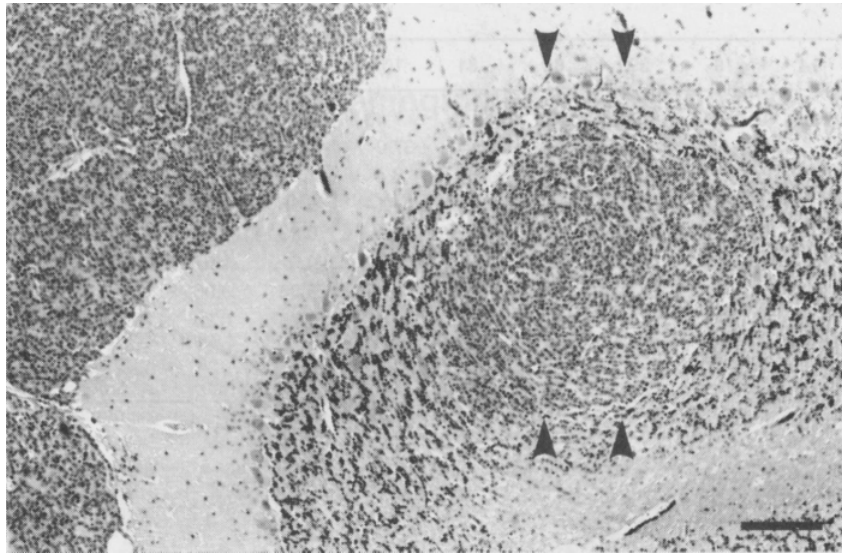
Fig. 3: Meningotheliomatous meningioma. Cerebellum. Neoplasm on the left inducing compression of the adjacent molecular layer and with the presence of an invasive neoplastic nodule (arrowheads) in the granular layer. Bar = 100 µ m. Haematoxylin and eosin.